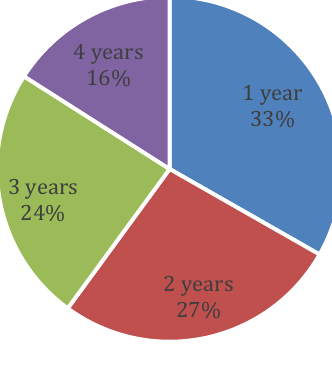
Figure 2. Proportion of Deaths by age for